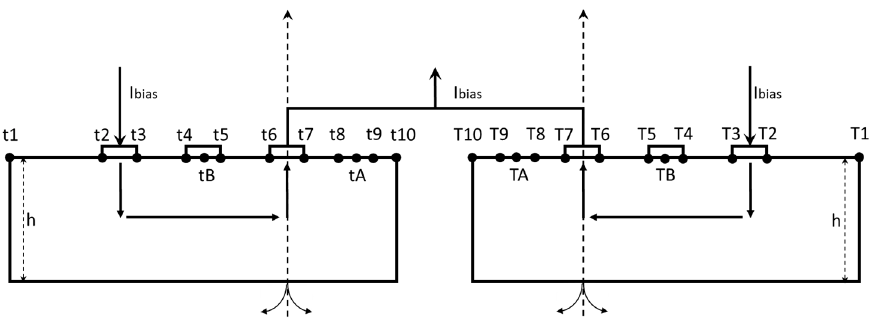
Figure 2. Double three-contact structure.